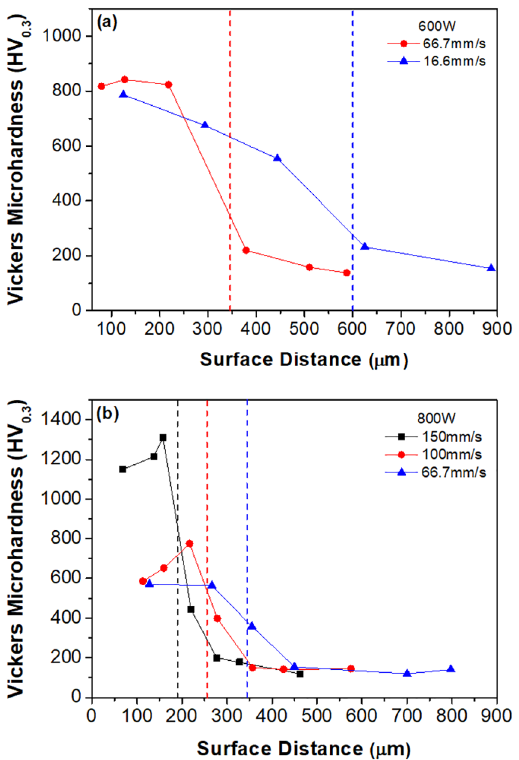
Figure 4. Vickers microhardness profiles of cross sections of the Fe Cr Nb B (at%) + 5wt% MoS 60 8 8 24 (a) 600W and (b) 800W. The scanning speeds used are indicate in the figures.The dashed lines indicated the thickness of the coating in each